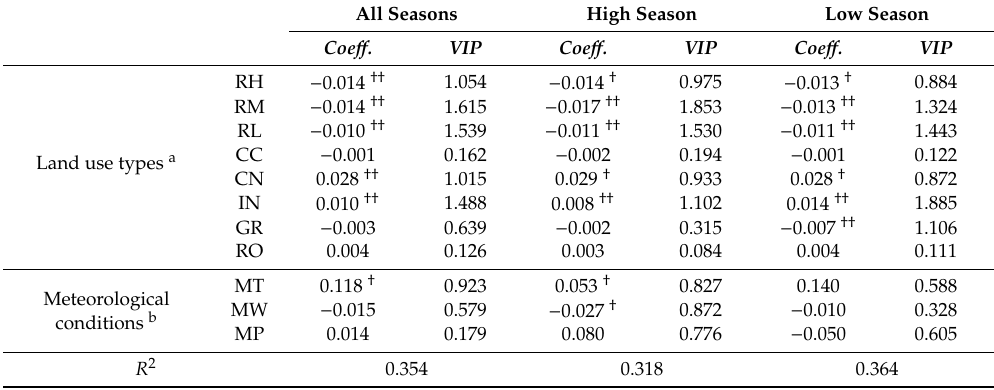
Table 5. Estimation of PM 10 levels based on land use classification II using PLS regression models. All Seasons High Season Low Season Coe ff . Coe ff . Coe ff .